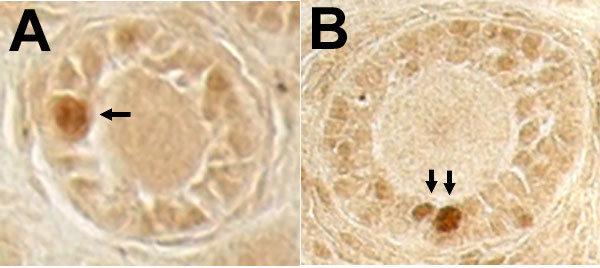
Immunolocalization of PPARγ in select cells of primary (A) and primary/secondary (B) follicles in ovarian tissue sections collected from neonatal rats. Tissues were collected and processed as described in the Methods. PPARγ is identified by the brown reaction product. Arrows indicate granulosa cells expressing high levels of PPARγ. Original magnification = 200×.